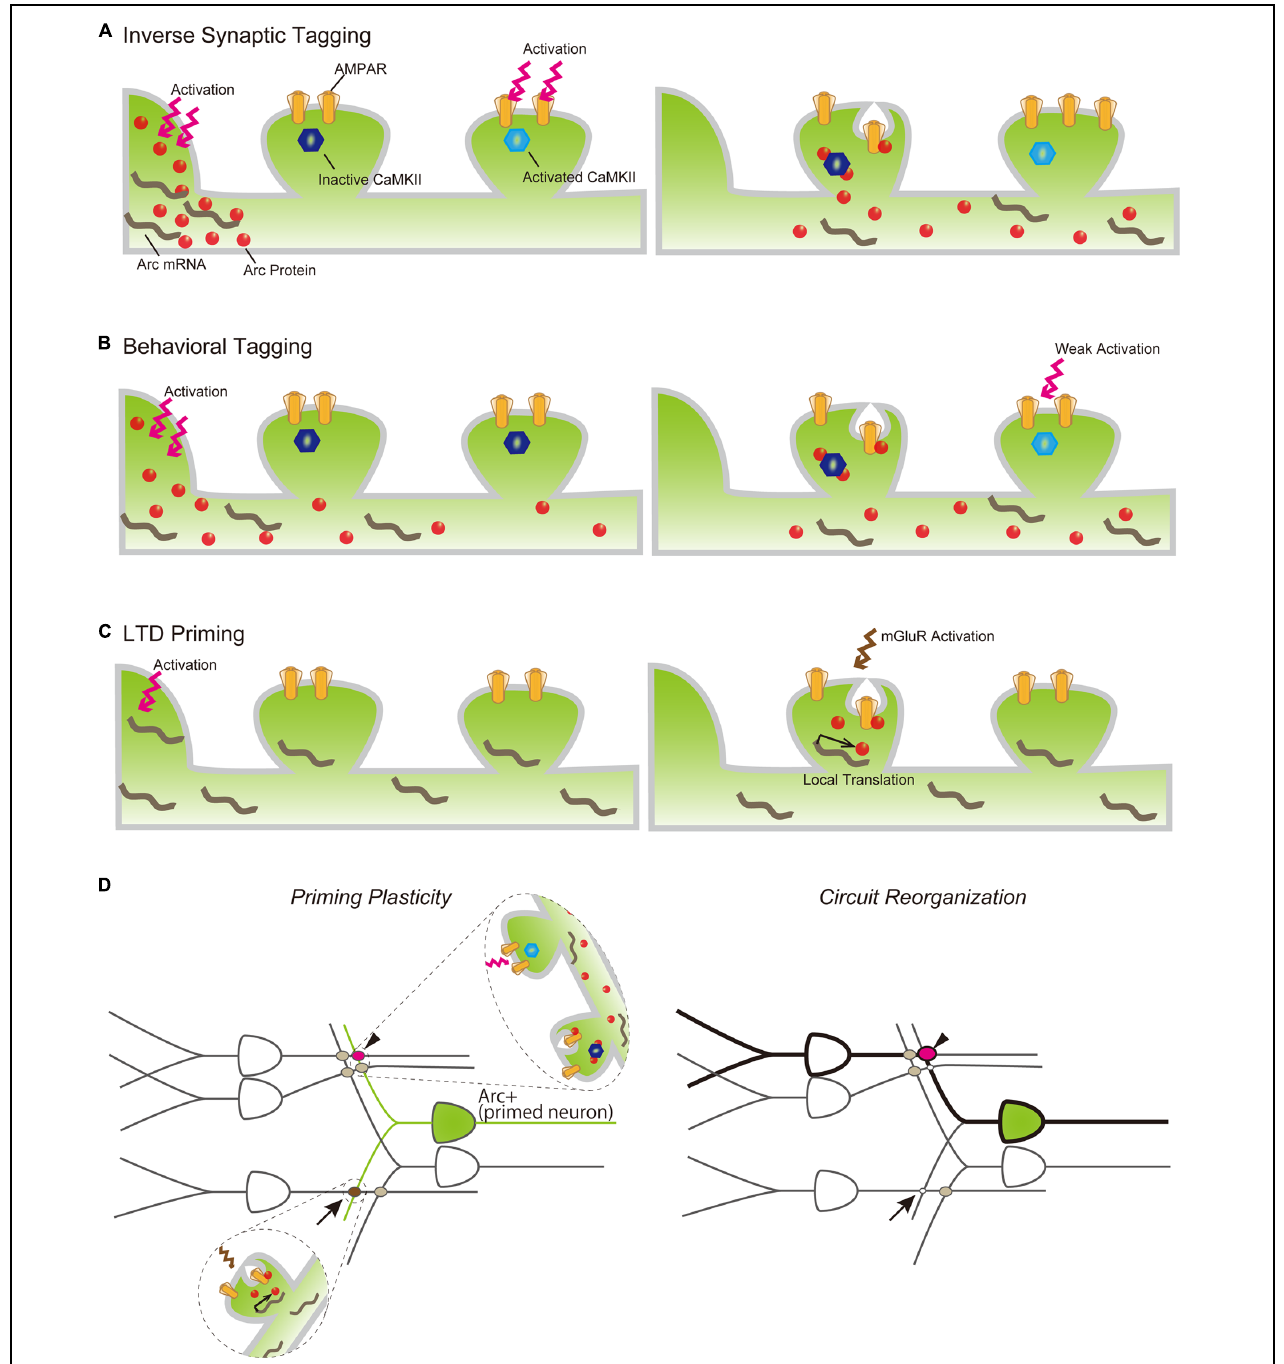
FIGURE 3 | Models of Arc mRNA and protein dynamics in inverse tagging (A), behavioral tagging (B), and LTD priming (C) processes. (A) Arc protein is synthesized in the soma following neuronal activation (left) and transported to an activated dendrite (right). Arc preferentially binds to the inactive form of CaMKII and promotes AMPAR endocytosis in the inactive synapse, resulting in the increasing synaptic strength of the activated synapse. (B) A novel exploration task induces Arc protein expression (left). Arc protein diffuses throughout the dendrite, decreases AMPAR in the non-tagged synapse, and serves to maintain the enhanced synaptic strength of synapses transiently potentiated by a weak training (right). (C) Other types of behavioral experiences promote Arc mRNA synthesis in the nucleus and transport to nearby synaptic sites, but its translation is suspended (left). Subsequent mGluR activation promotes Arc translation from dendritically localized Arc mRNA, resulting in AMPAR internalization and LTD of the mGluR-activated synapse. (D) Arc expression plays a permissive role in inducing synapse-specific plastic changes to organize a new memory trace following a new behavior/experience. Arrow and arrowhead indicate LTD-primed and behavioral-tagged synapses,